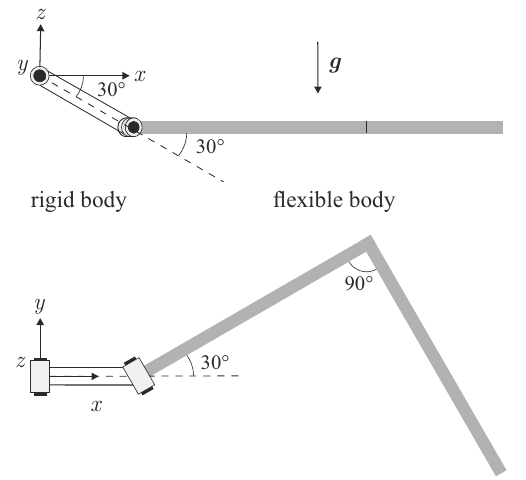
Figure 9. Geometry of a double pendulum consisting of a rigid and a flexible body, as proposed in Sugiyama et al. (2003).